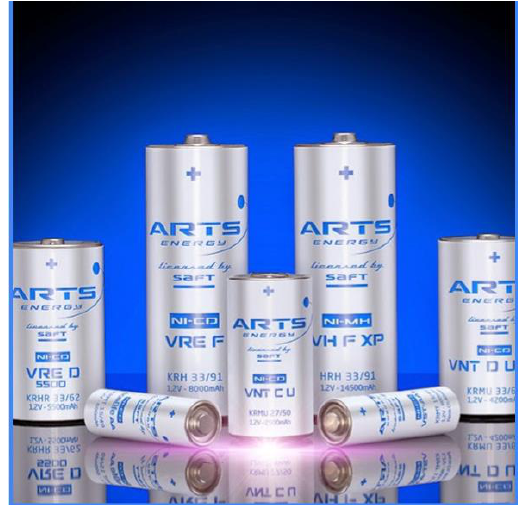
Figure 3. Cylindrical cells from Arts Energy [53].